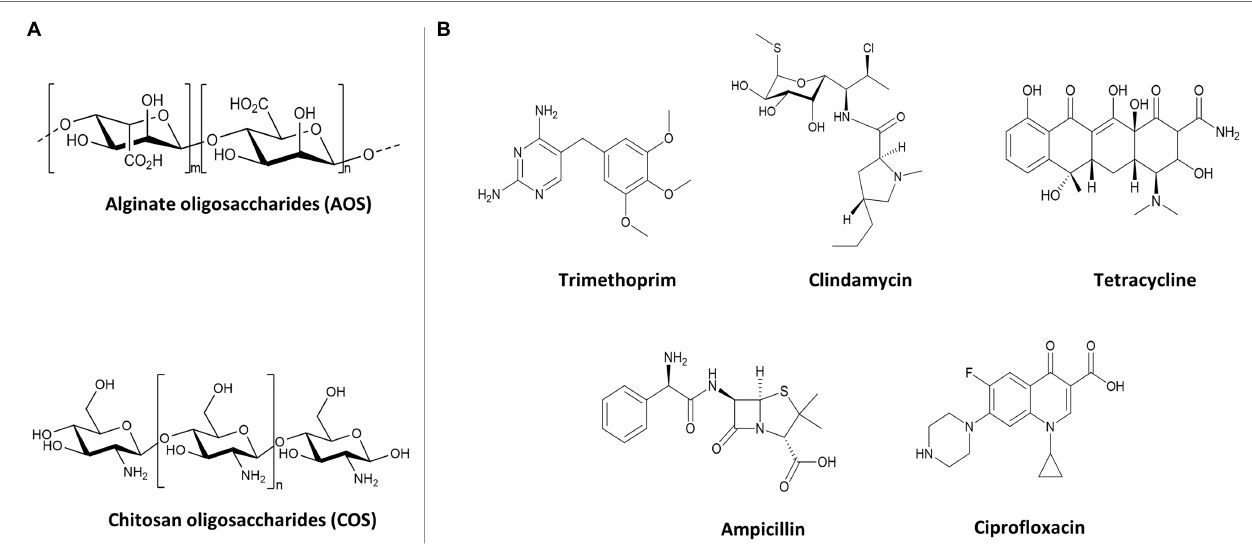
FIGURE 1 | Structures of oligosaccharides and antibiotics used for antimicrobial activity against GBS V and S. aureus wood 46. (A) Structures of AOS and COS. (B) Structures of bacteriostatic (TMP, CLI, and TET) and bactericidal (AMP and CIP)